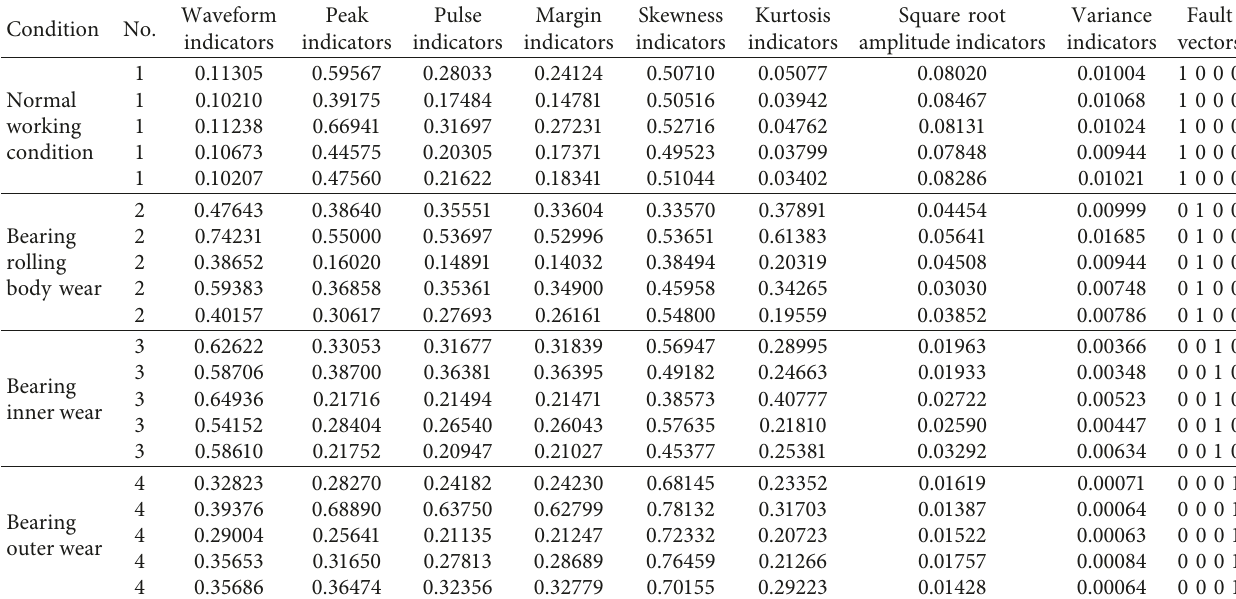
Table 2: Gearbox rolling bearing part of the training